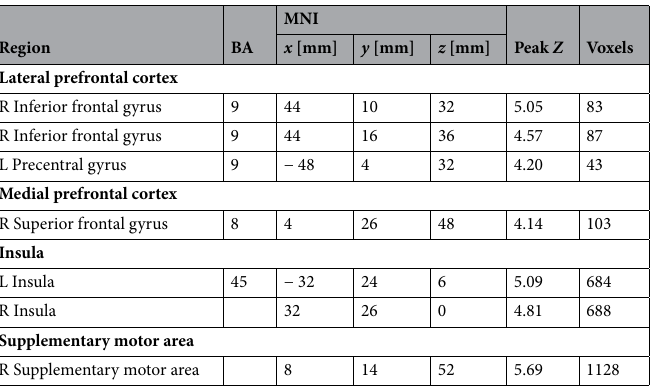
Table 3. MNI coordinates of the activated clusters in trial 3. In this trial, a stimulation current amplitude that was 0.5 times that of the standard amplitude was applied. Threshold values of uncorrected p and cluster extent k were set as smaller than 0.001 and more than 20, respectively. L left hemisphere; R right hemisphere.